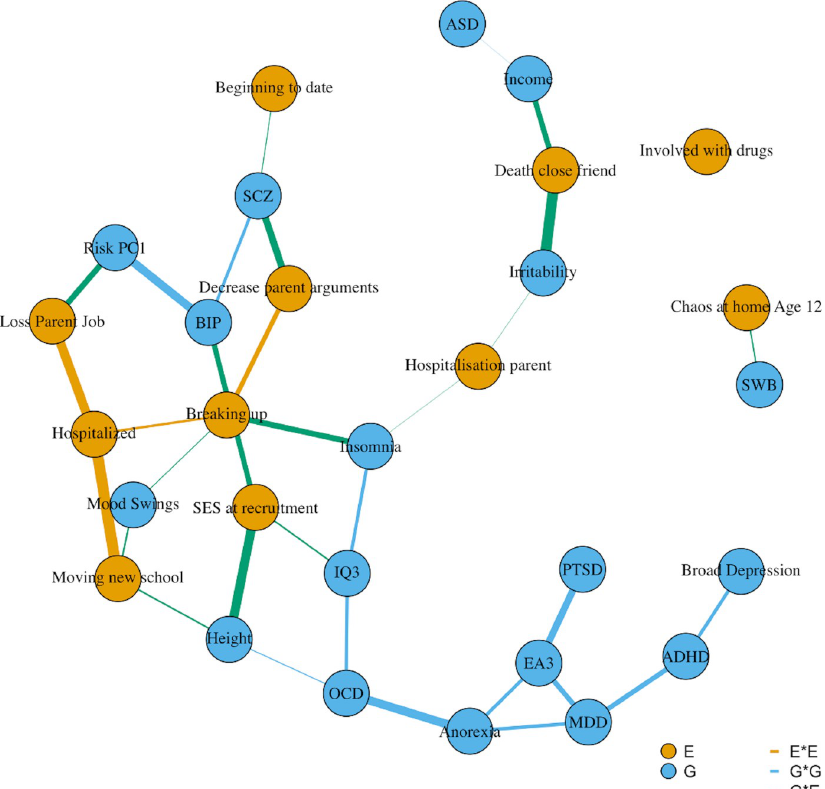
Fig 3. Interaction network of glinternet model. Note. Edges width represent interactions weights. E = Environmental measure, G = Genome-wide polygenic score. Polygenic scores acronyms: ASD = Autism Spectrum Disorder, ADHD = Attention-Deficit Hyperactivity Disorder, BIP = Bipolar Disorder, EA3 = Educational Attainment, IQ3 = Intelligence, Income = household income, MDD = Major Depressive Disorder, SWB = Subjective Well-Being, OCD = Obsessive Compulsive Disorder, PTSD = Post-Traumatic Stress Disorder, Risk PC1 = First Principal Component of Risky behaviors, SCZ = Schizophrenia.